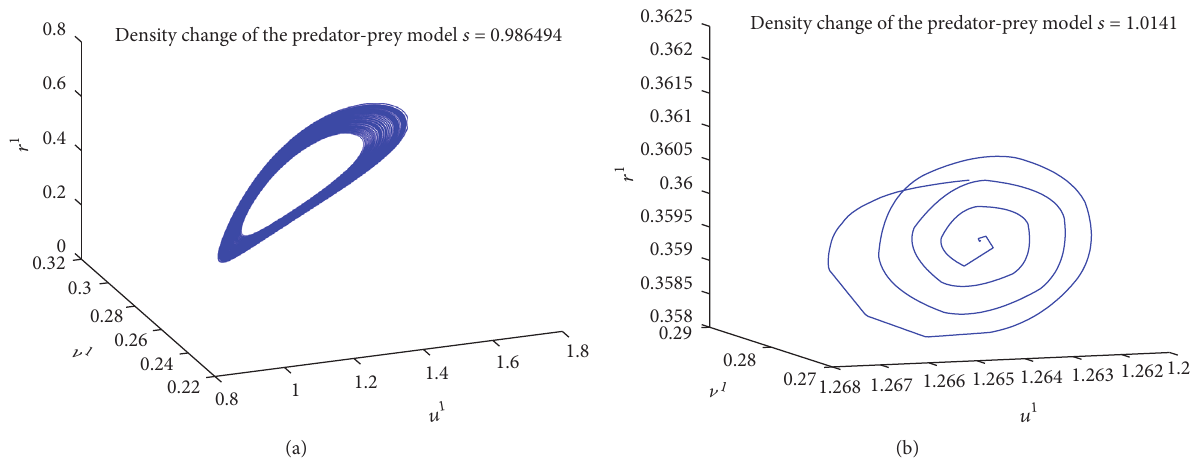
Figure 7: Here we take the parameters as mentioned earlier from [26], 𝑟 = 0.5 , 𝑚 = 1 , 𝑢 = 0.1 , 𝛾 = 1.5 , 𝑡 1 = 1.3 . With 𝑠 = 0.986494 , Φ < 0 , from Figure 5, and we clearly see limit cycle dynamics, as expected in (a). Now if we take 𝑠 = 1.0141 , where Φ > 0 , from Figure 5, we see a stable spiral, again as expected, in